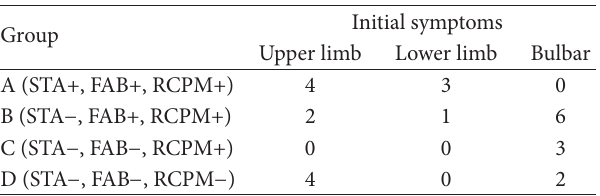
Table 3: The distribution of patients according to the initial symptoms and the results of STA, FAB, and RCPM.